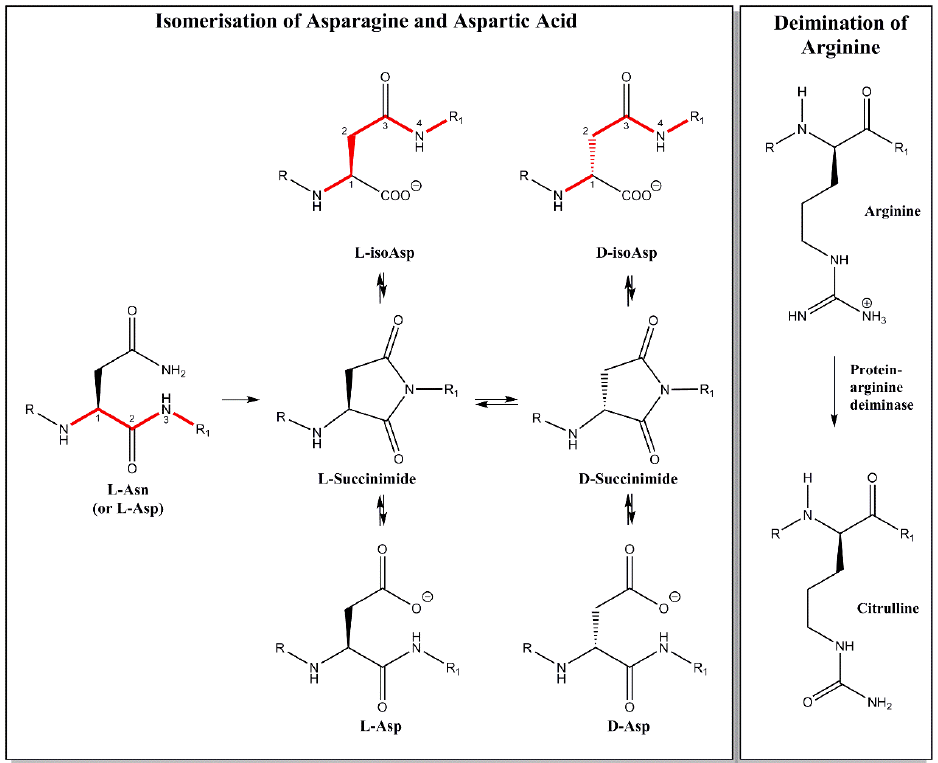
Figure 1. When old proteins in the body degrade, novel structures are formed. L -Asp and L -Asn residues can spontaneously convert over time to 4 isomeric forms, via a cyclic intermediate as illustrated. An uncharged Asn becomes a mixture of four negatively charged Asp residues. Probably of greatest impact as potential immune inducers are L -isoAsp and D -isoAsp. In the case of D -isoAsp the α -carbon is racemised and the polypeptide chain is also extended by the insertion of a CH 2 group, as highlighted by the red bonds. In adult MBP, many positively charged Arg residues have been converted to neutral citrulline residues. Together these abundant post translational modifications (PTMs) lead to protein unfolding and the generation of novel antigens.